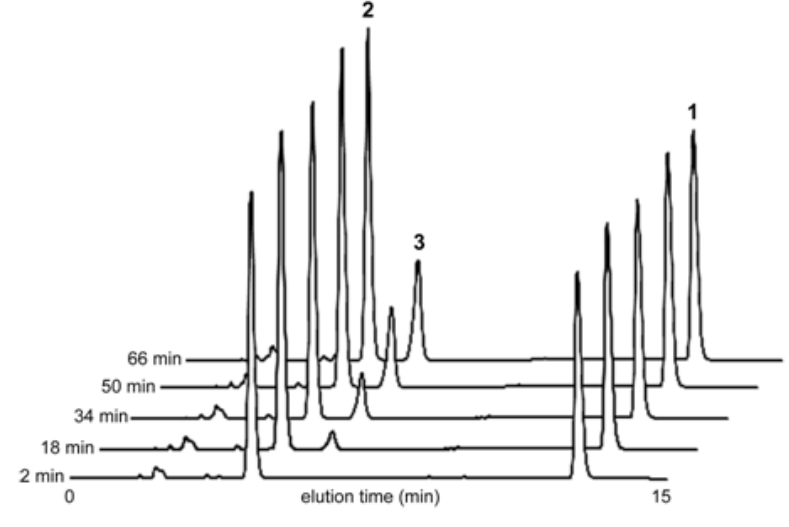
Figure 4. HPLC traces of 7 mol % Eu(OTf) O/THF (v/v) after 2, 18, 34, 50, and 66 min. The increase in peak 3 with time H 2 corresponds to an increase in product concentration. The y-axis shows absorbance at 210 nm in arbitrary